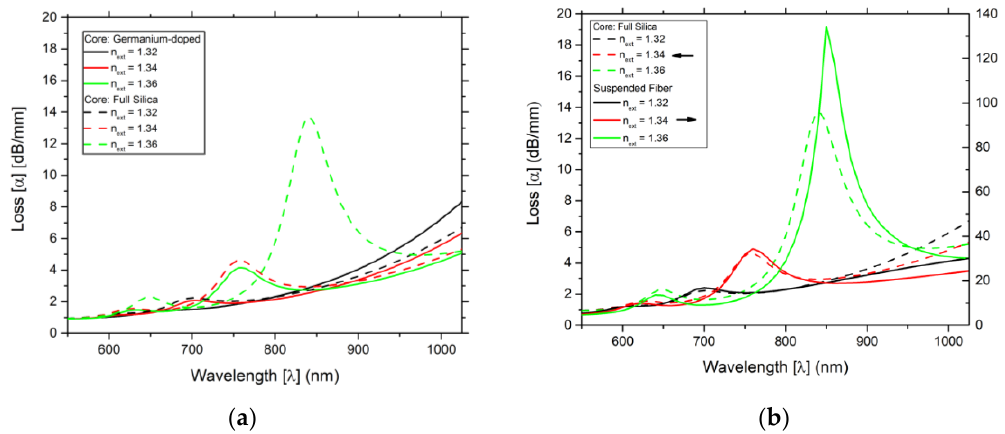
Figure 4. Loss as function of wavelength for different values of the external refractive index of 1.32 to 1.36. ( a ) Results for the D-type fiber sensing structures with a core of pure silica. ( b ) Results for the D-type fiber with a core of pure silica and for the suspend core fiber structures. Notice that the losses for the losses for the pure silica fiber are measured on the scale on the left, while the suspended core fiber are measured on the scale on the right.